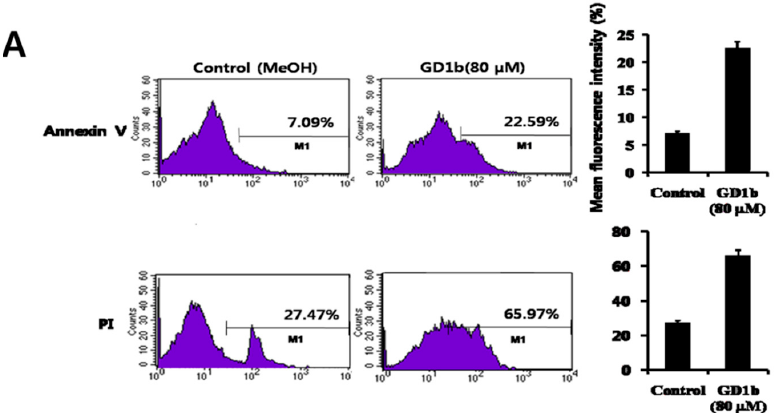
Figure 2. Effect of various gangliosides on MCF-7 cell growth. ( A ) The cytotoxicity of various gangliosides on the MCF-7 cells has been examined using an XTT kit for cell growth assay. The cultured cells (approximately 1 × 10 4 cells) in 96-well microplates (volume, 100 µL/well) for 24 h with various gangliosides were checked for the cytotoxicity; ( B , C ) The cytotoxicity of the GD1b on the MCF-7 cells was evaluated using an XTT cell proliferation assay kit. Cells were exposed to GD1b at various concentrations (0 to 80 µM) and also incubated with time course (1, 3, 6, 12 and 24 h). Control was treated with methanol (8 µL/100 µL) only. The absorbance at a wavelength of 490 nm was then measured using a digitalized ELISA reader (Molecular Devices, Sunnyvale, CA, USA). Data are reported as the percentage change in comparison with the control group, which were arbitrarily assigned as 100% viability. Data represent five experiments (means ± SD). * p < 0.01 vs. control.